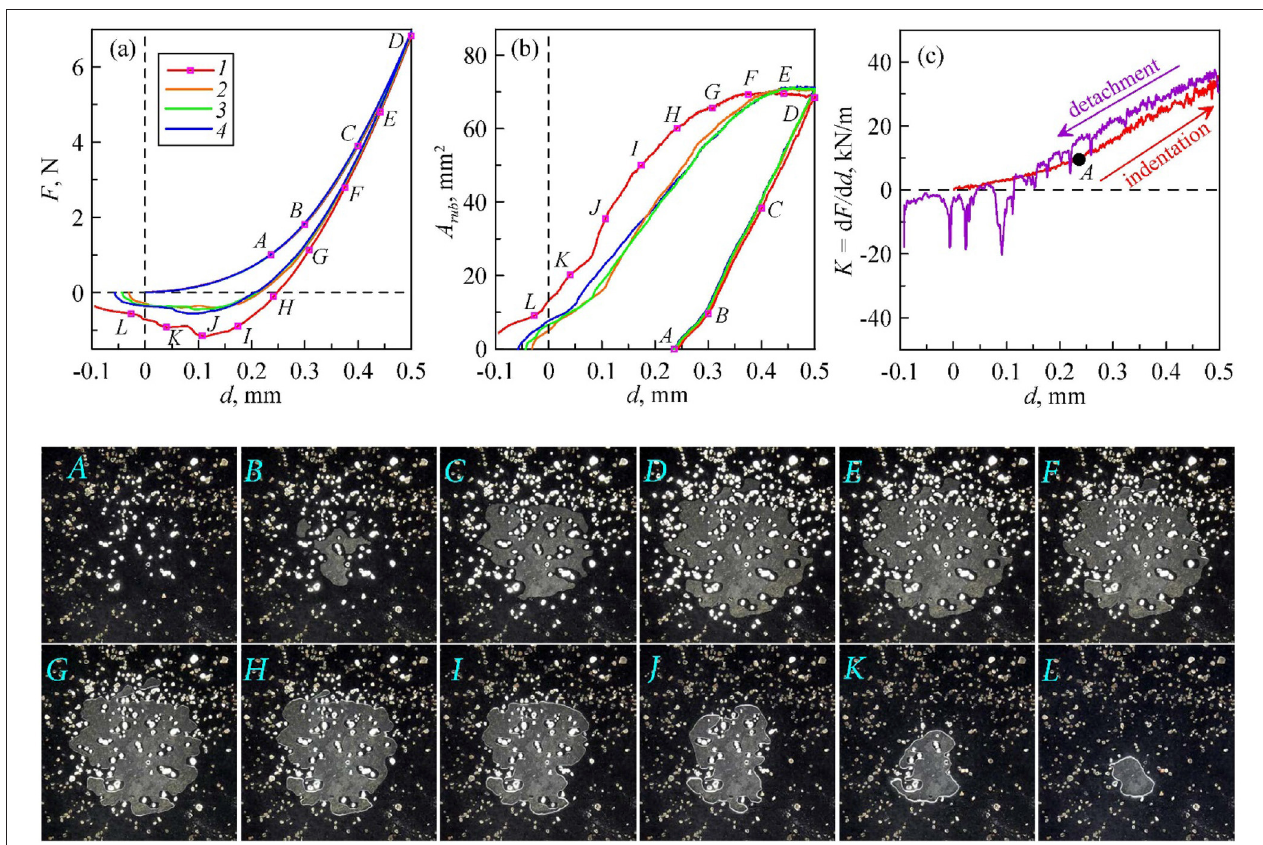
FIGURE 6 | Experiment of indentation of a smooth steel sphere in a rubber sheet with sand particles in the interface. Dependences of: (a) the normal force, (b) contact area between elastomer and indenter, and (c) contact stiffness on indentation depth. Solid lines with different colors show the four experiments in a series. Contact stiffness is shown only for the first indentation cycle. The snapshots below show contact areas with size 17mm × 17mm for the first indentation cycle, corresponding to the points marked in panels (a,b)